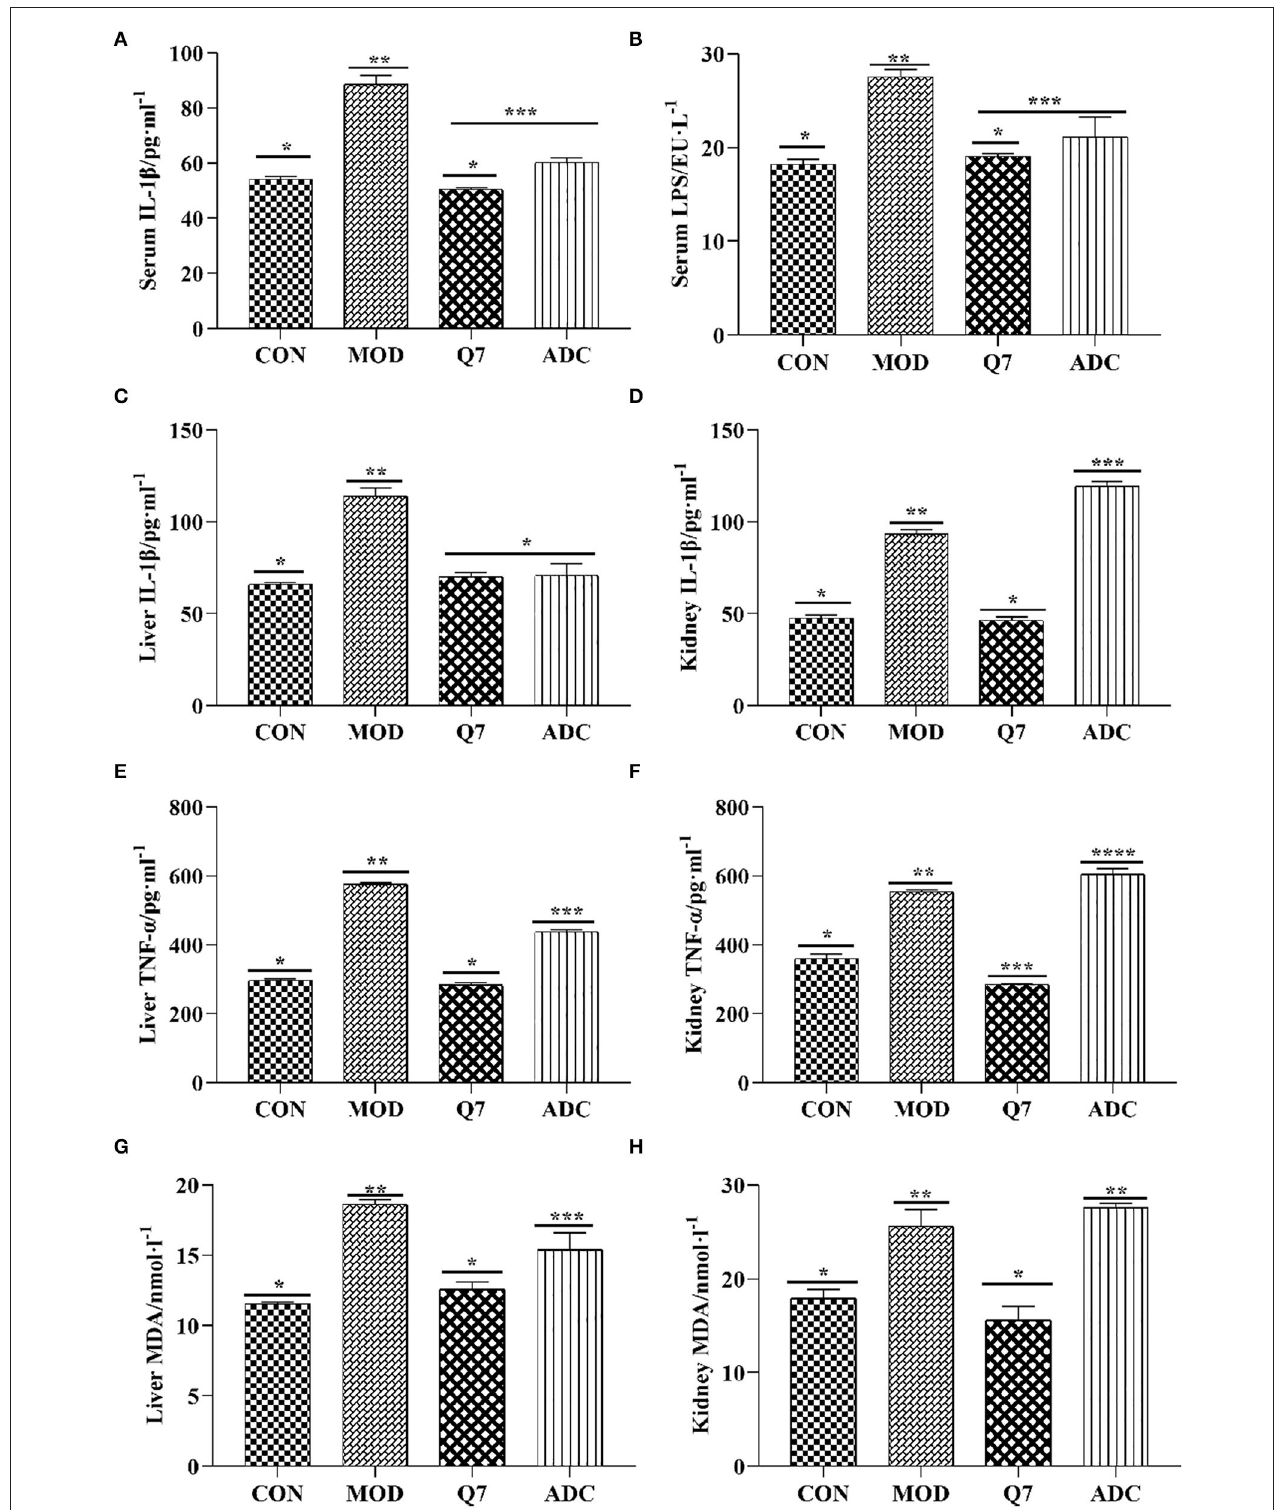
FIGURE 5 | Effects of L. plantarum Q7 on the pro-inflammatory factors of mice. (A) Serum IL-1 β ; (B) Serum LPS; (C) Liver IL-1 β ; (D) Kidney IL-1 β ; (E) Liver TNF- α ; (F) Kidney TNF- α ; (G) Liver MDA; (H) Kidney MDA.